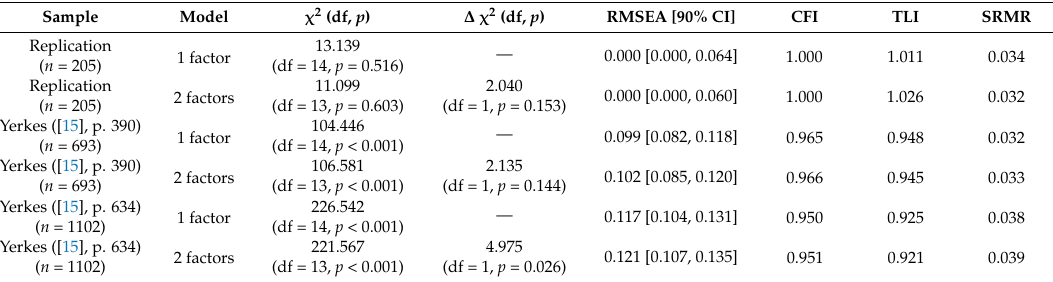
Table 4. Confirmatory Factor Analysis Results for Army Beta